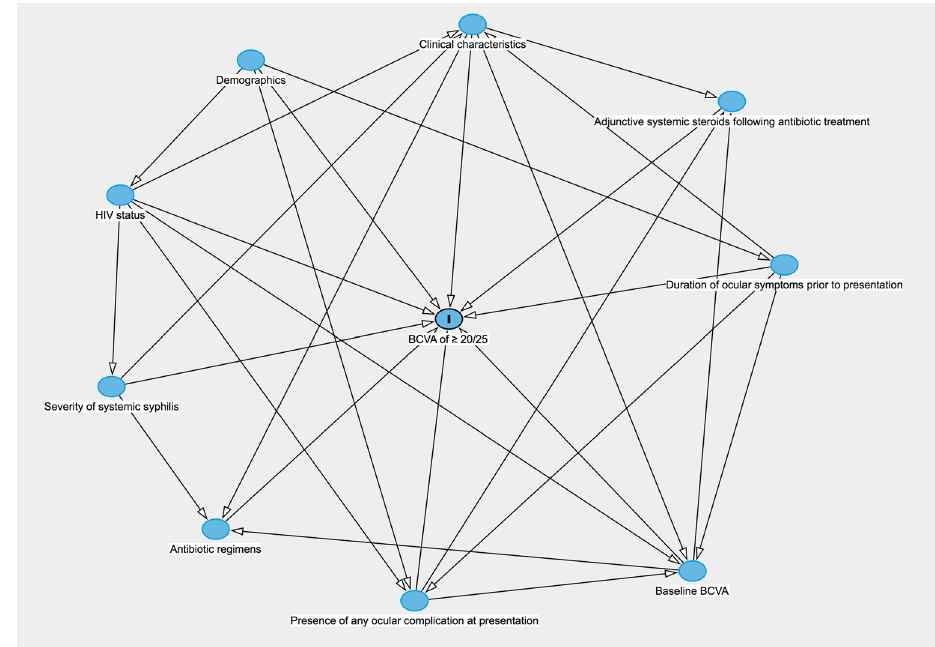
Figure 1. Theoretical model of the association between all variables of interest and improvement of visual acuity following antibiotic therapy based on a directed acyclic graph (DAG). BCVA, best corrected visual acuity; HIV, human immunodeficiency